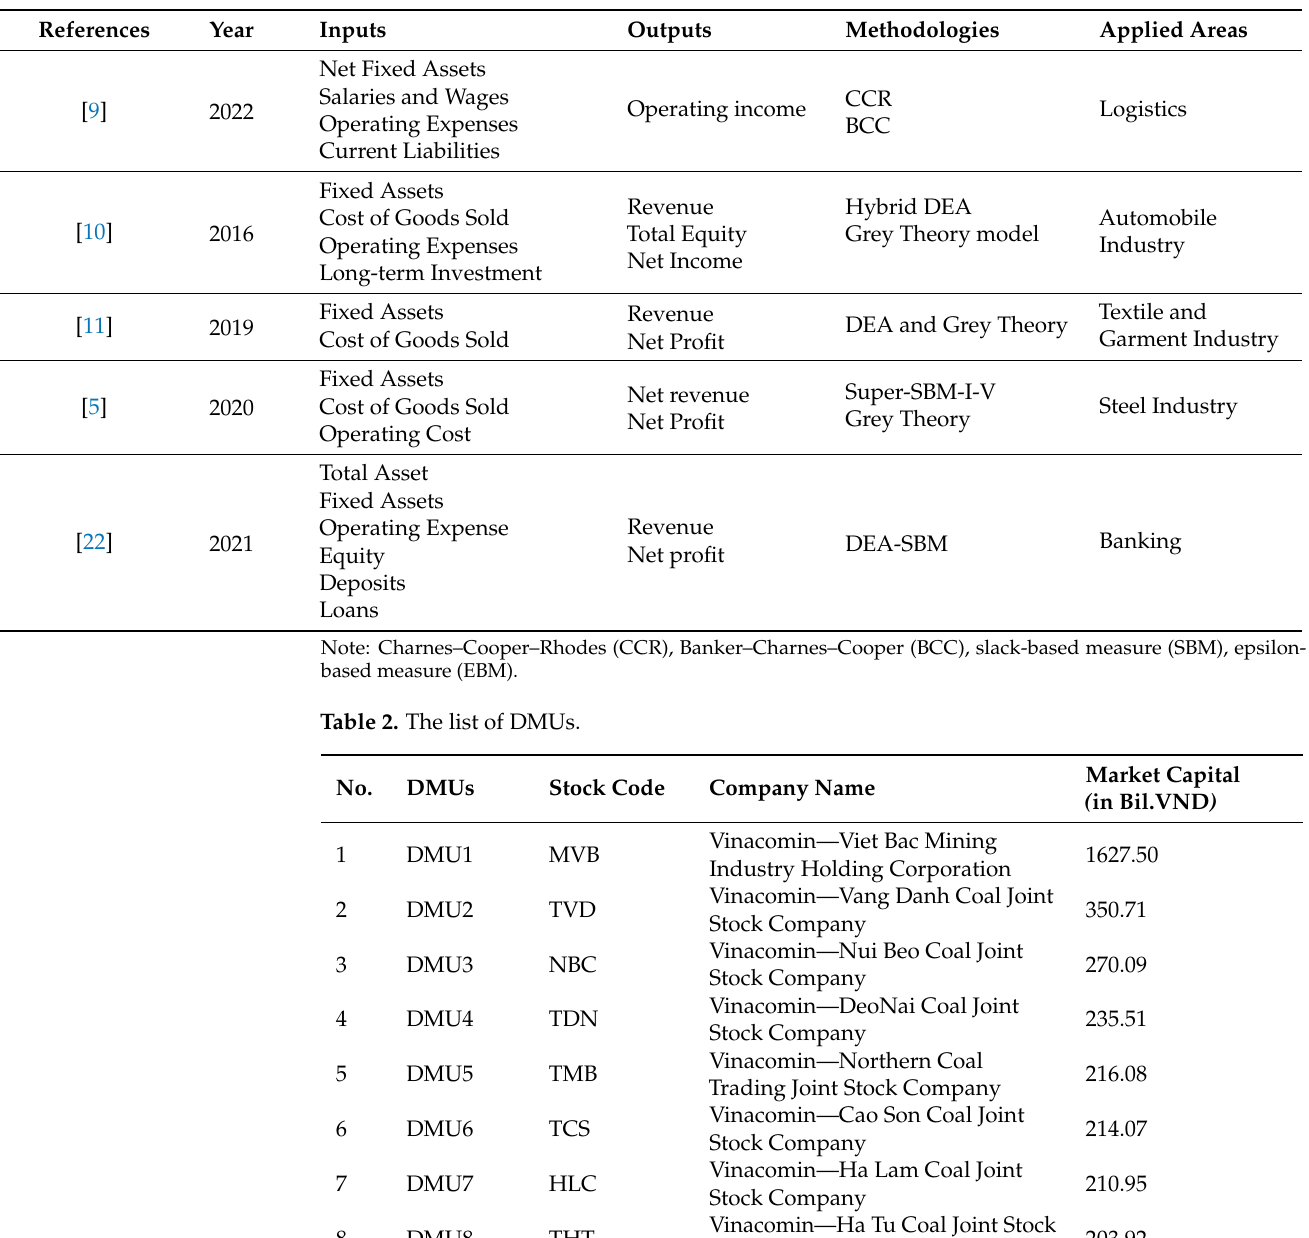
Table 1. Summary of methodologies and inputs/outputs selection in previous studies.